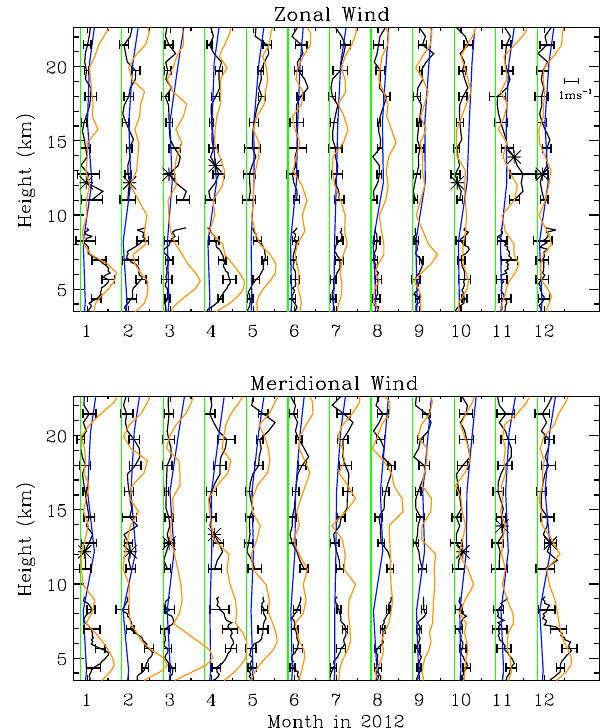
Figure 4. Comparison between the fitted monthly amplitude of the diurnal tide in 2012 (black curve along with error bars) and those amplitudes from the MERRA data set “inst6_3d_ana_Nv” (orange) and GSWM-02 (blue) in zonal wind (top) and meridional wind (bot- tom). The green vertical lines represent zeros. The asterisks repre- sent the heights of the tropospheric